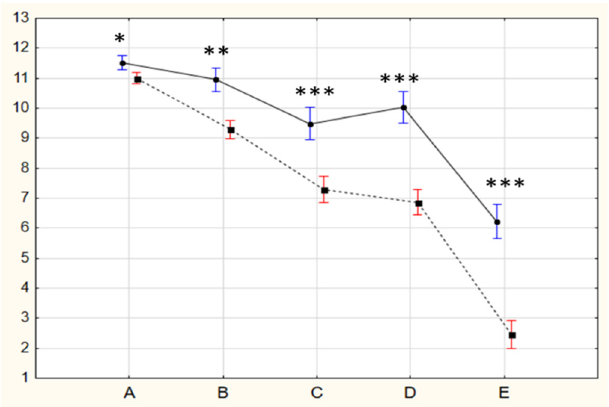
Figure 2. The numbers of correct answers in the five series of the Raven’s test for schoolchildren (dashed line) and students (solid line). Significance is *— p < 0.0002, **— p < 0.00005, ***— p < 0.000001.